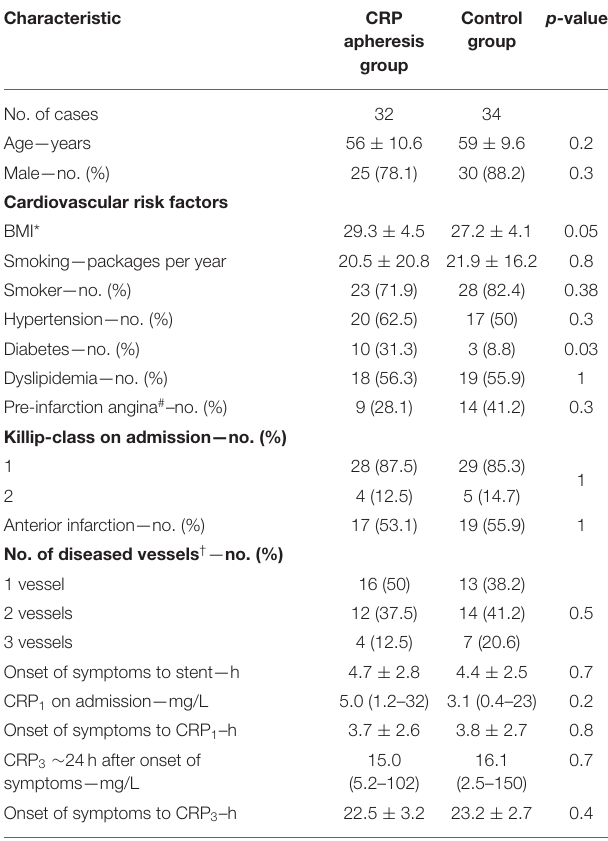
TABLE 1 | Baseline characteristics of the study